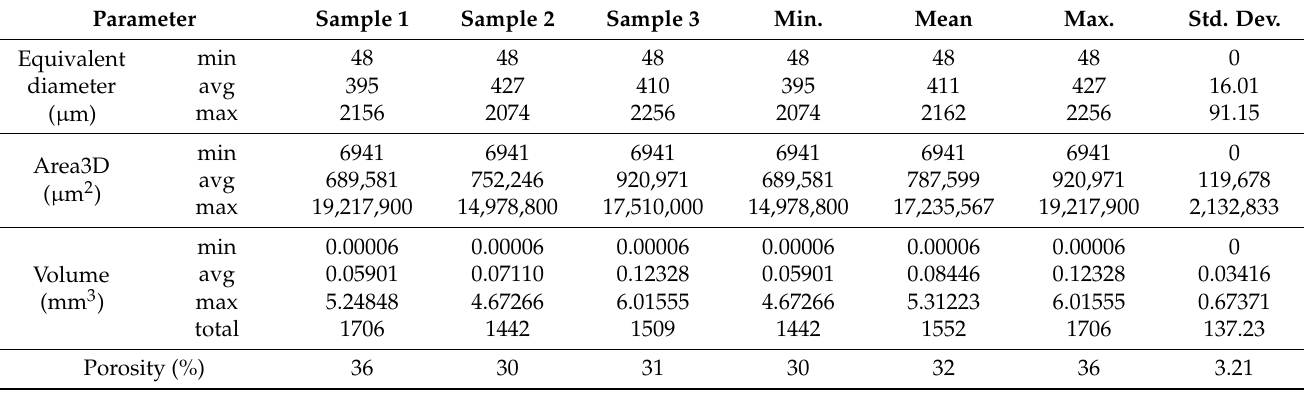
Table 1. Values of the morphological parameter (equivalent diameter) of the analyzed porous biomaterial samples. Parameter Sample 1 Sample 2 Sample 3 Min. Mean Max. Std.